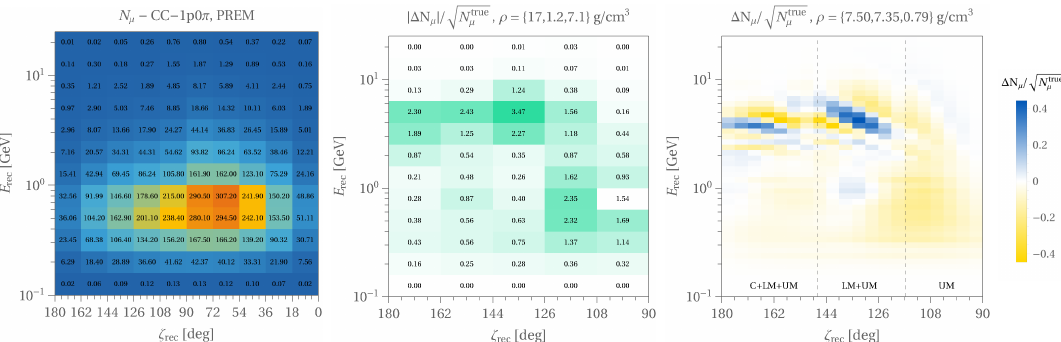
Figure 17 . Left : number of charged current muon neutrino events with one proton and no pions in the final state (CC-1p0 π ) for an exposure of 400 kt-yr, taking into account cross section and detector effects, as a function of the reconstructed neutrino energy and zenith angle, assuming δ and NO. Middle : statistical power of CC-1p0 π sample, see text for details. Right : statistical power of CC-1p0 π sample for the 40 × 60 binning used in our simulations; the darkest blue and yellow p N true correspond to ∆ N = 0 . 44 , − 0 . 44 , µ / µ